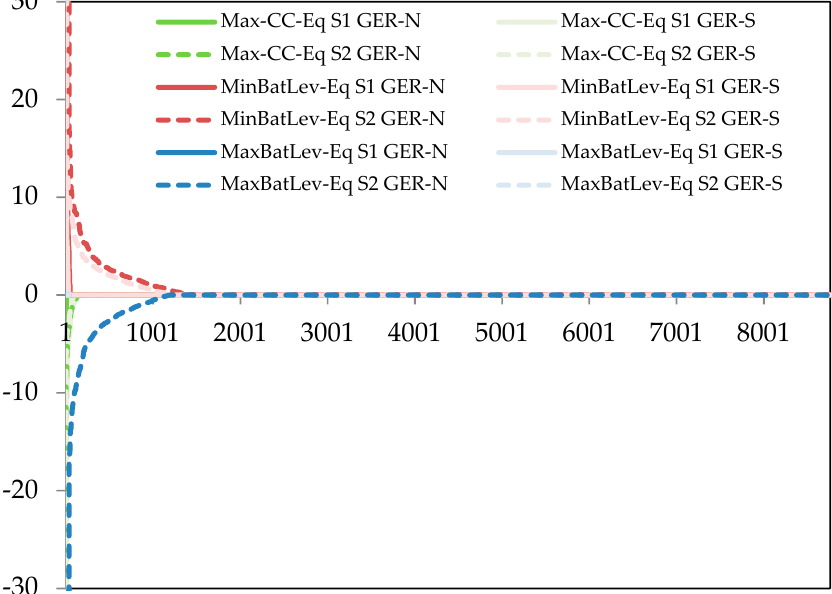
Figure A13. Duration curves of marginals of constraint equations. Max-CC: Equation constraining the power of controlled charging because of grid connection of EV fleet. MinBatLev: SOC min constraint. MaxBatLev: SOC max constraint. Curves are given solid for scenario S1 and dashed for scenario S2. Results for Southern Germany are given in light colors.